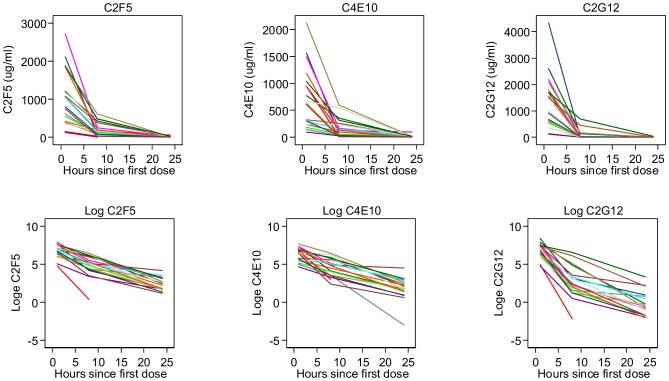
Antibody and loge antibody concentrations over three time points for individual participants given active Mabgel (high and low dose) without adjustment for dilution factors.